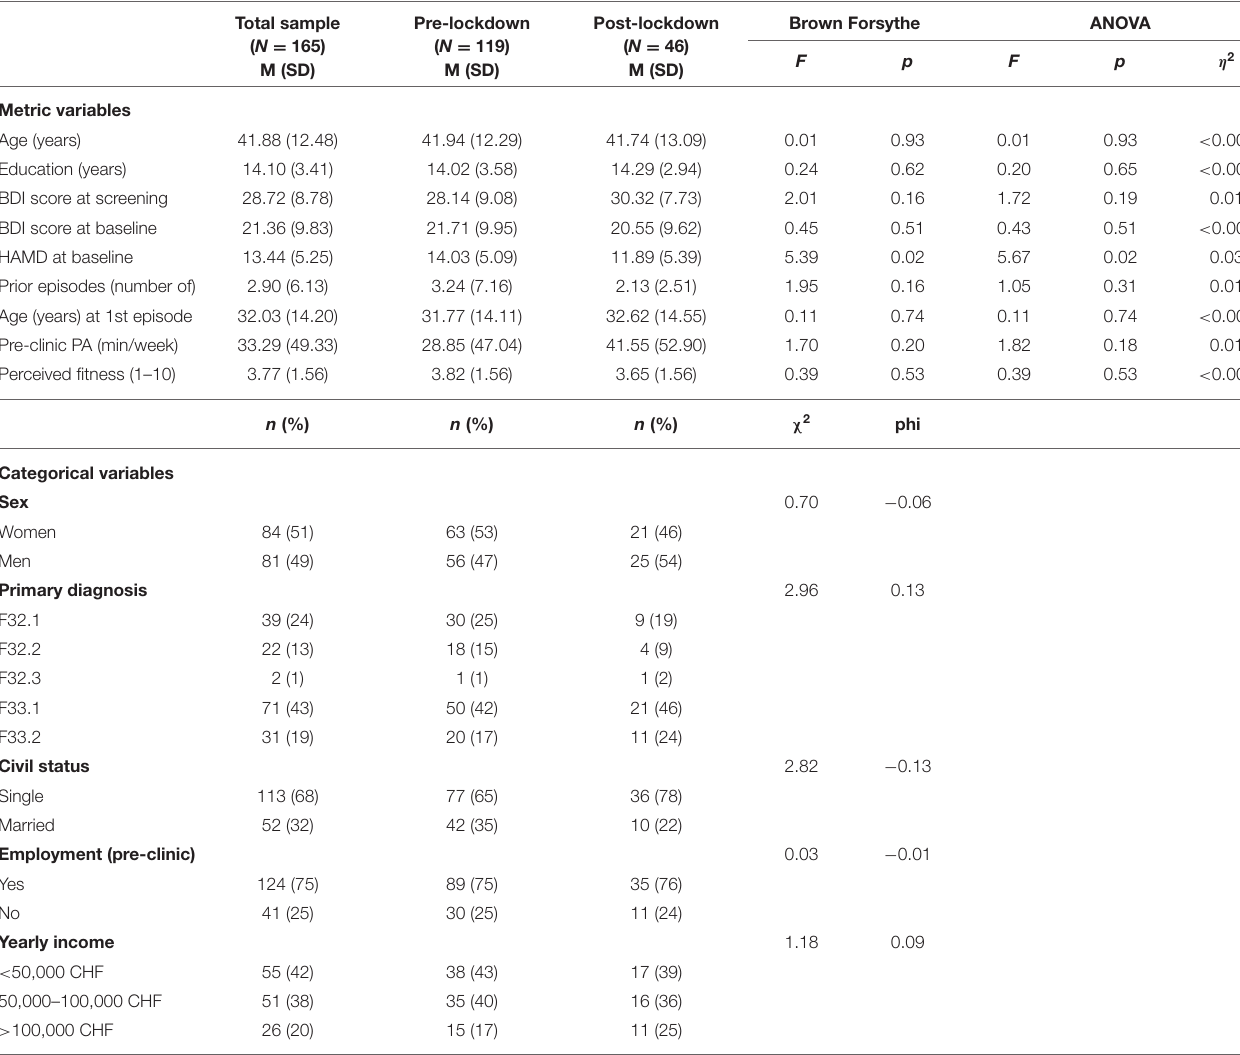
TABLE 1 | Descriptive statistics and differences in potential confounders.